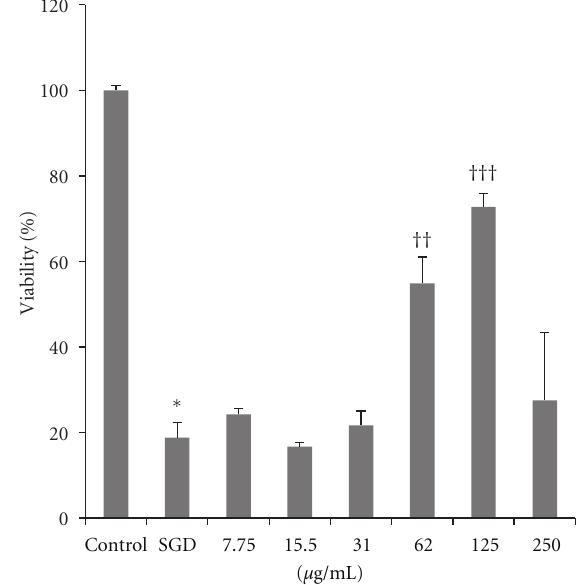
Figure 1: Protective e ff ects of S. litwinowii on serum/glucose deprivation-induced cytotoxicity in PC12 cells. PC12 cells were pretreated with S. litwinowii (7.75–250 μ g/mL) for 2h and then were exposed to serum/glucose deprivation for an additional 24h with respective original concentrations of S. litwinowii . The incubation in the high-glucose medium during the whole treatment period served as control group, and the treatment only with serum/glucose-free medium for 24 h served as serum/glucose deprivation alone group. The cell viability was expressed as the percent (%) of the control value by using MTT assay. The data presented are means ± SEM of three independent experiments ( n = 3). ∗ : P value < 0.001 relative to control group; †† : P value < 0.01 relative to SGD; ††† : P value < 0.001 relative to